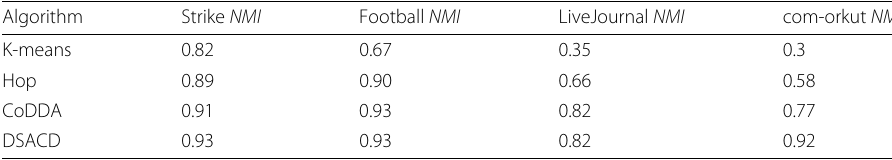
Table 6 The analysis of community detection results